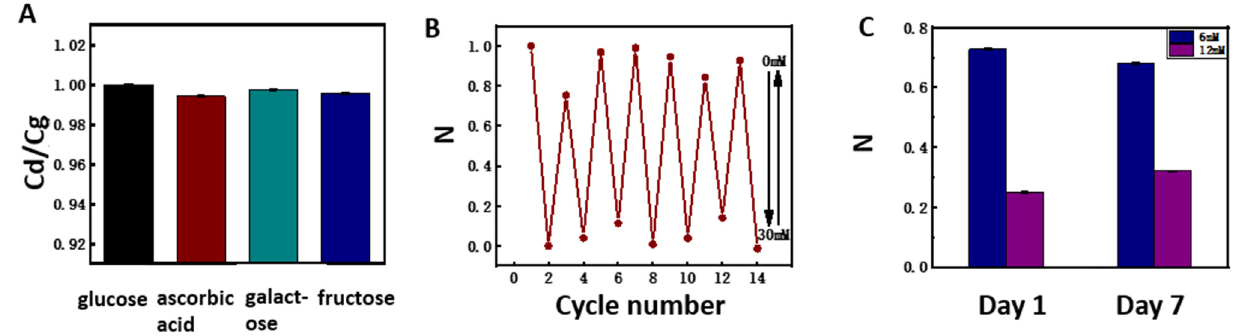
Figure 4. ( A ) Capacitance in response to disturbances in 5 mM glucose buffer solution. The disturbances include galactose, ascorbic acid, and fructose at concentrations of 0.5 mM. ( B ) Reversible capacitance response of the DexG–Con A hydrogel sensor immersed in glucose solution with repeated concentration changes between 0 and 30 mM at 30 kHz. ( C ) Stability test of the capacitive glucose sensor.